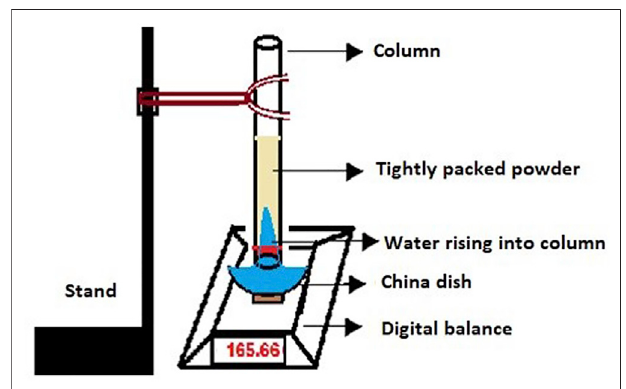
FIGURE 1 | Illustration of the setup used for the estimation of the Washburn